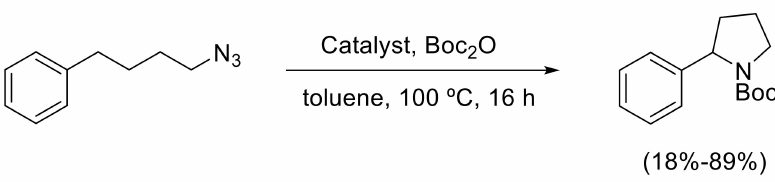
Scheme 58. Catalytic intramolecular ring-closing C-H bond amination starting from (4-azidobutyl)benzene as substrate with formation of the corresponding pyrrolidine.